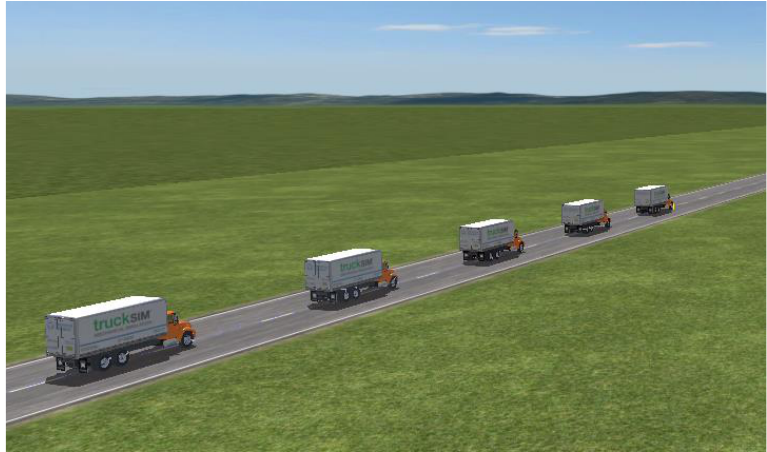
Table 1. The proposed method is applied in the co-simulation environment and displayed in TruckSim, as shown in Figure 7, under dynamic communication conditions.